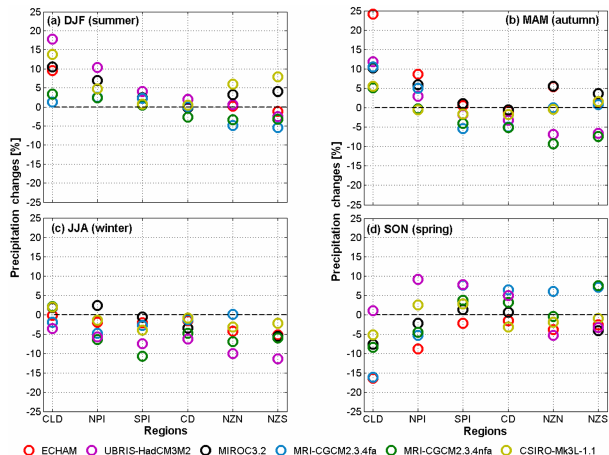
Figure 3. Precipitation differences: mid-Holocene minus pre- industrial, over the six zones of analysis. (a) DJF, (b) MAM, (c) JJA, and (d) SON. Filled circles correspond to statistically significant dif- ferences ( p ≤